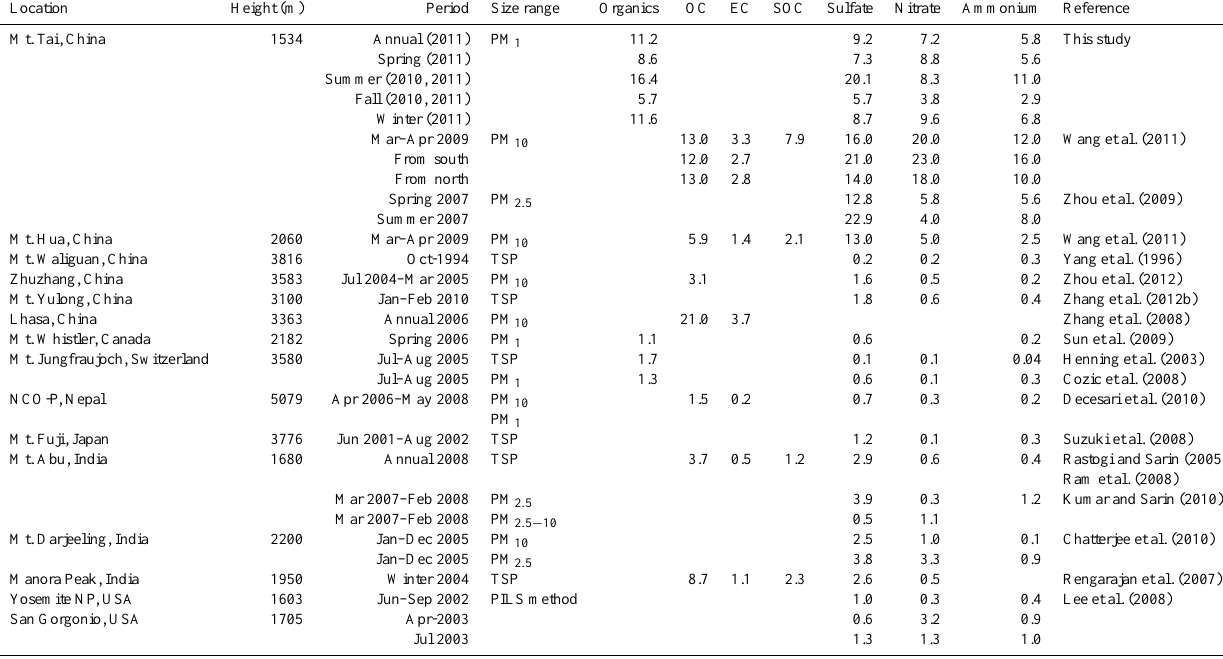
Table 1. The concentration of main aerosol chemical species at Mt. Tai compared to other mountain stations, SOC represents secondary organic carbon. Data are provided in µgm − 3